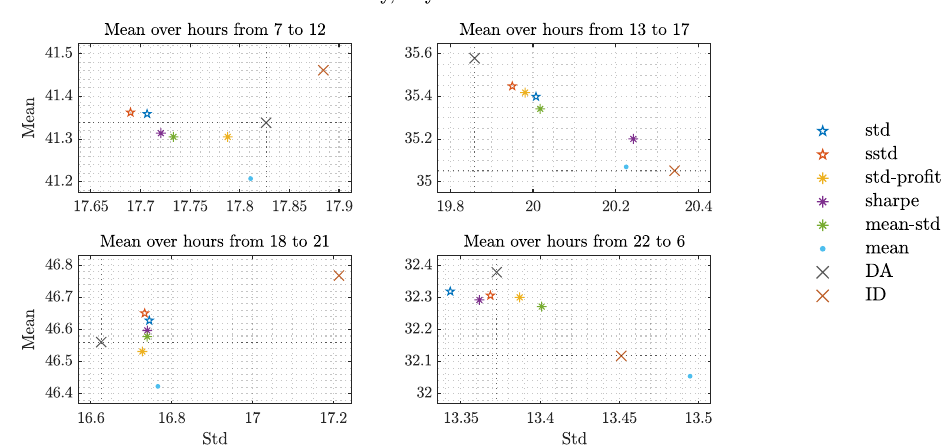
Figure 8. Average results of the portfolio allocation, ( σ h , t , E [ s h , t ]) obtained for a buyer in the German market using different strategies. The averages are calculated over all days in the validation window and hours within the considered blocks: 7–12, 13–17, 18–21, 22–6. The results of trading only on the day-ahead (DA) or intraday (ID) market are plotted for reference. Source: Authors’